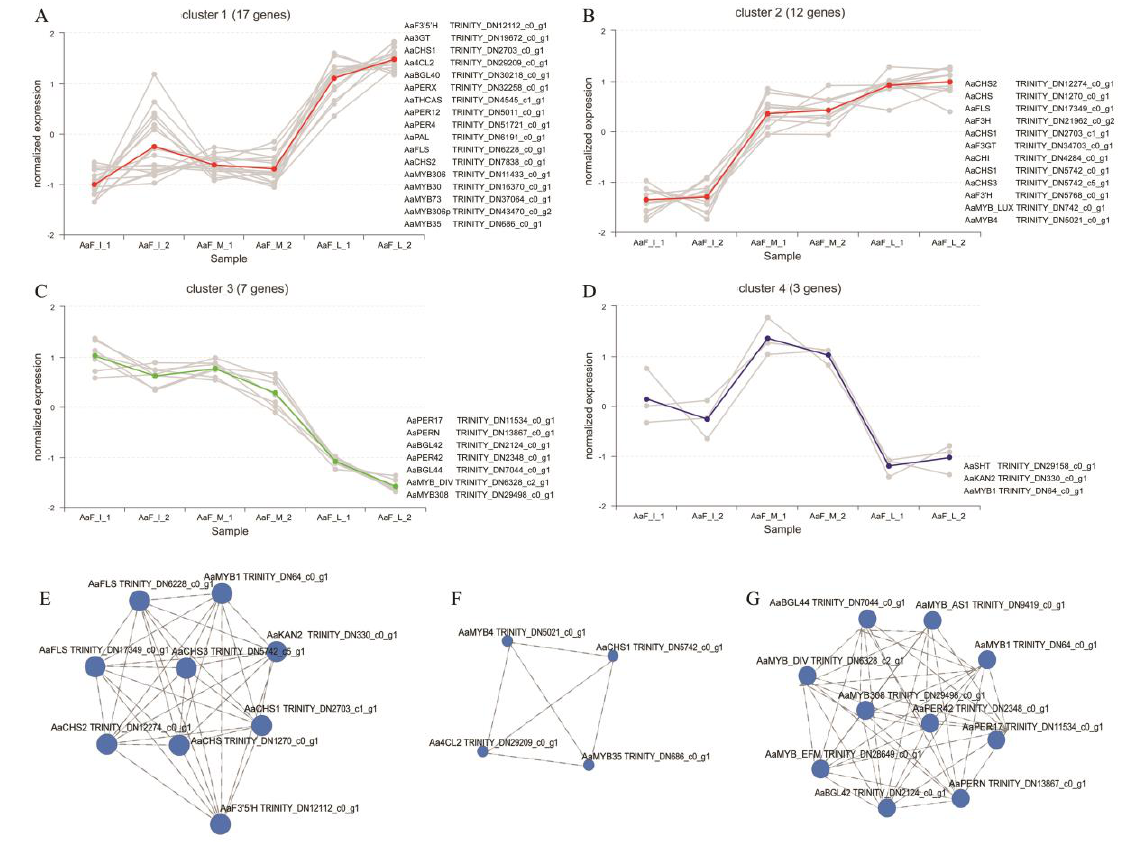
Figure 5. Expression pattern analysis of candidate genes involved with anthocyanin biosynthesis. ( A – D ), cluster trend analysis of candidate genes. Red line represents the overall upward trend, green line represents the overall trend of decline, blue line represents the trend rising first and then falling. ( E – G ), expression-correlation analysis of candidate genes by Spearman method.